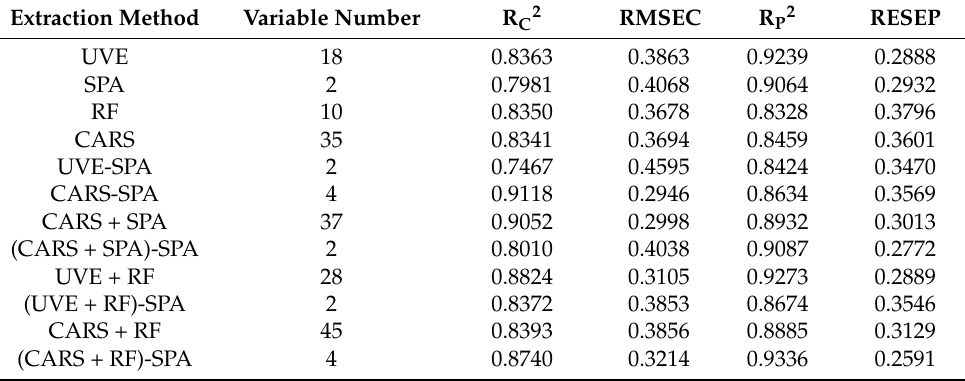
Table 6. Prediction results of ELM model established by different feature extraction methods. Extraction